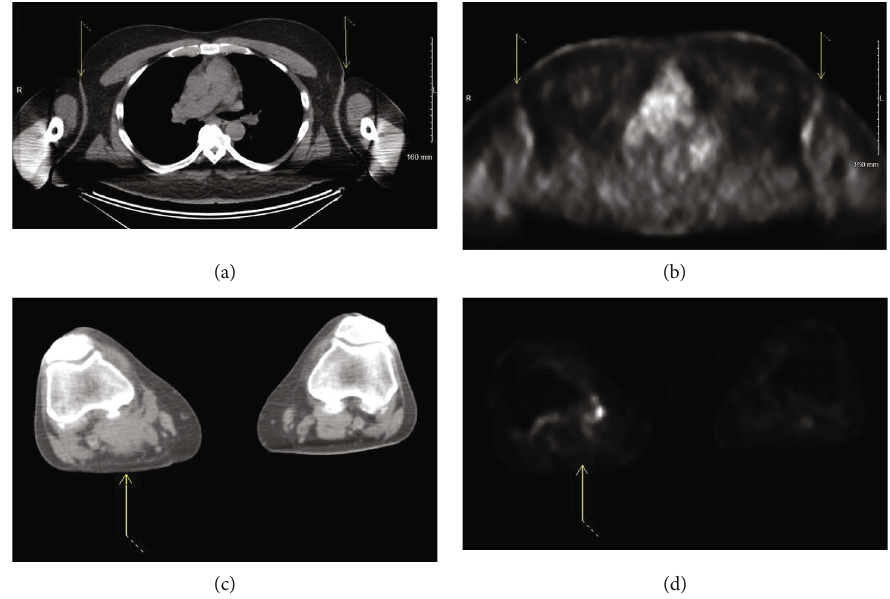
Figure 4: PET/CT imaging approximately 7 months after starting RT. Axial CT of patient axilla (arrows) (a) and corresponding PET image (b). Axial CT of patient ’ s right popliteal mass (arrow) (c) and corresponding PET image (d).